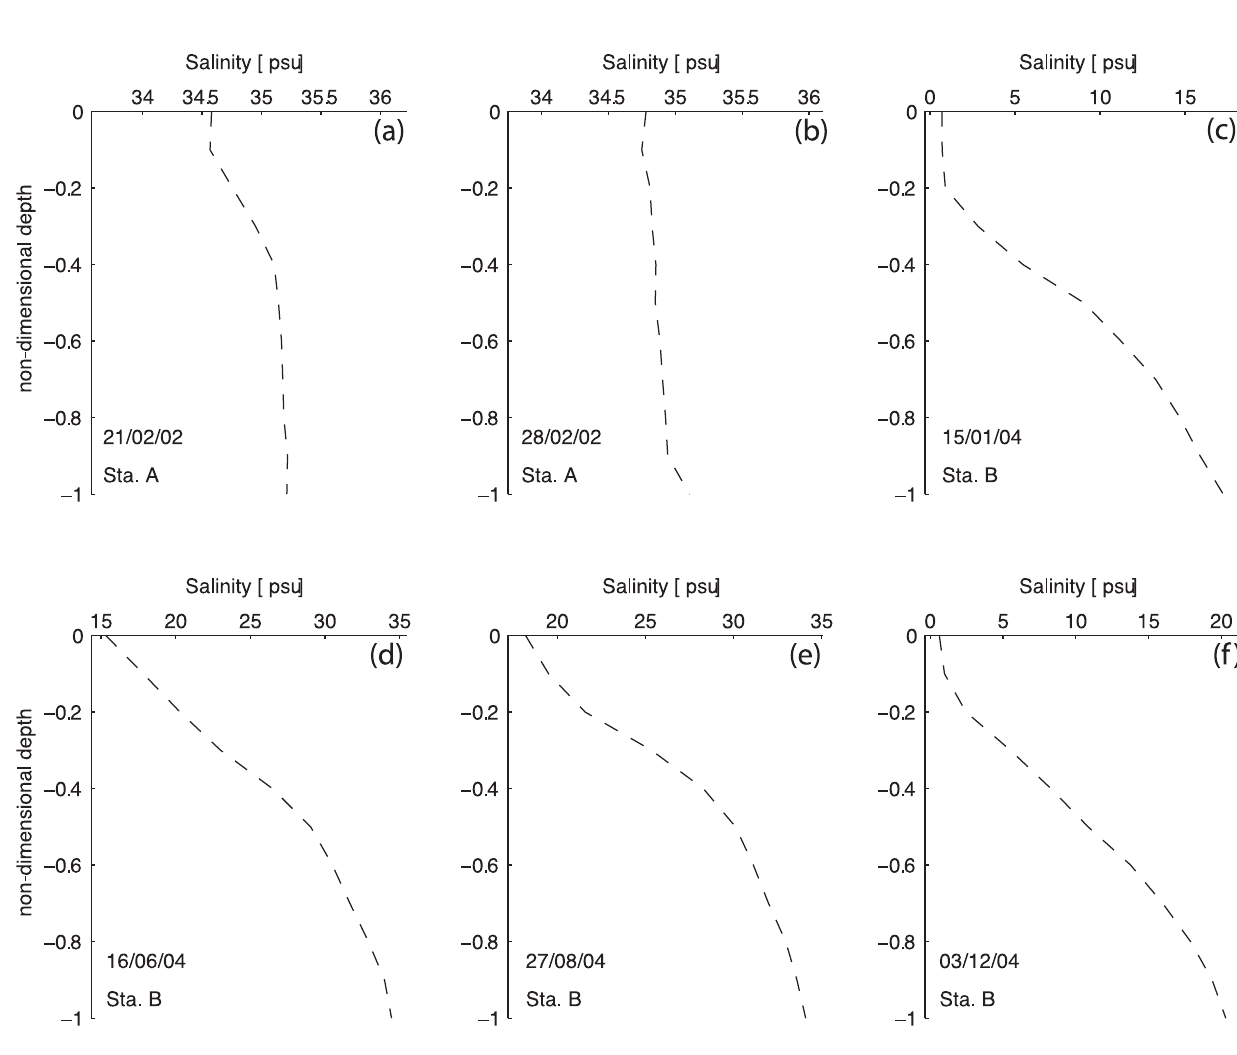
Figure 4. Profiles of non-tidal salinity at stations A and B. (Figure 5e) for the June and August surveys, respectively. The salinity profiles show brackish surface values with maxima of 15.3 and 18.2 during the June and August surveys, respectively. These values increase toward the bottom until values higher than 34.